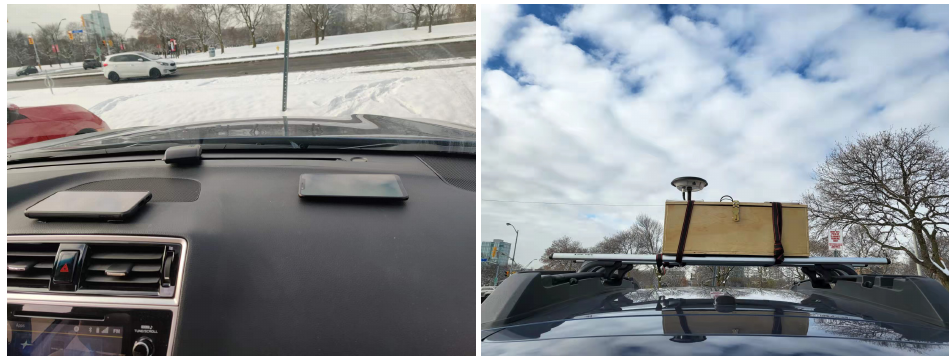
Figure 3. Photos of strapped reference sensors used in measurement